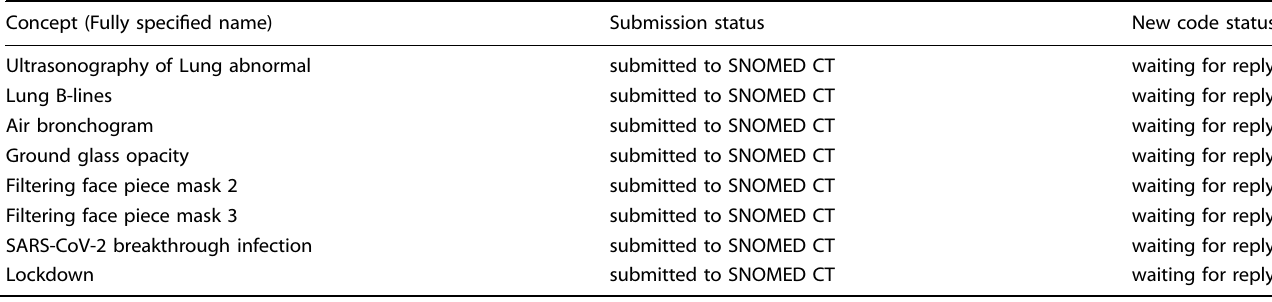
Table 5. Healthcare concepts used in ORCHESTRA studies that were submitted to SNOMED CT for new code assignment.